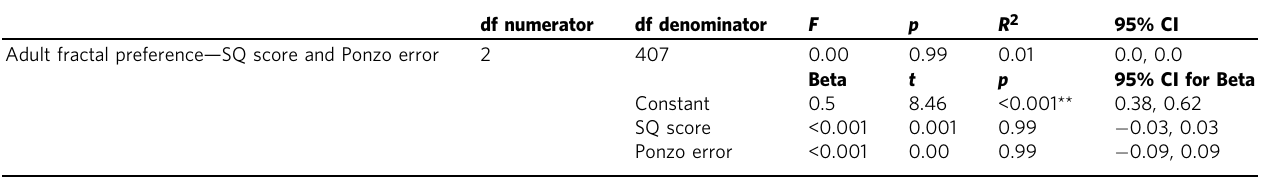
Table 6 Regression predicting adult fractal